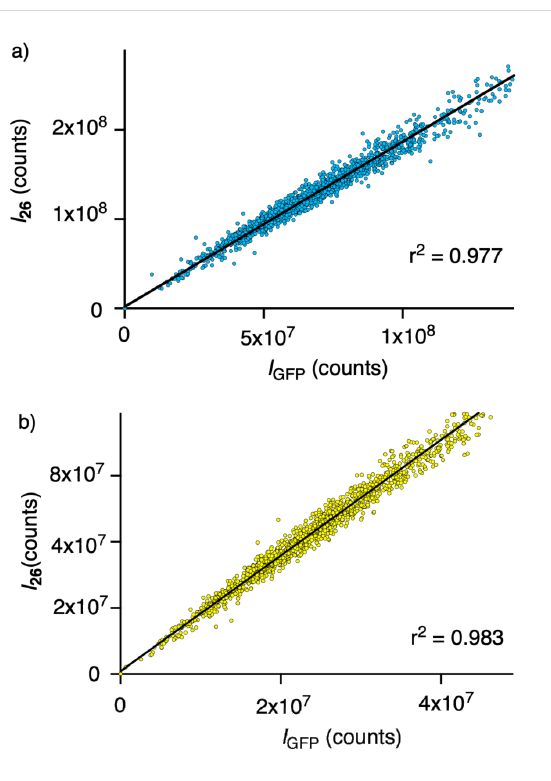
Figure 8: Evaluation of the automated HC imaging of stable HGM cells with HaloTag–GFP on mitochondria, labeled with 26 , showing the fluo- rescence intensity of GFP versus 26 in a) selected cells inside the cell body mask (light blue and yellow areas in Figure 7a) and in b) selected regions with a high GFP signal, considered as the mitochondrial network (yellow areas only in Figure 7a).